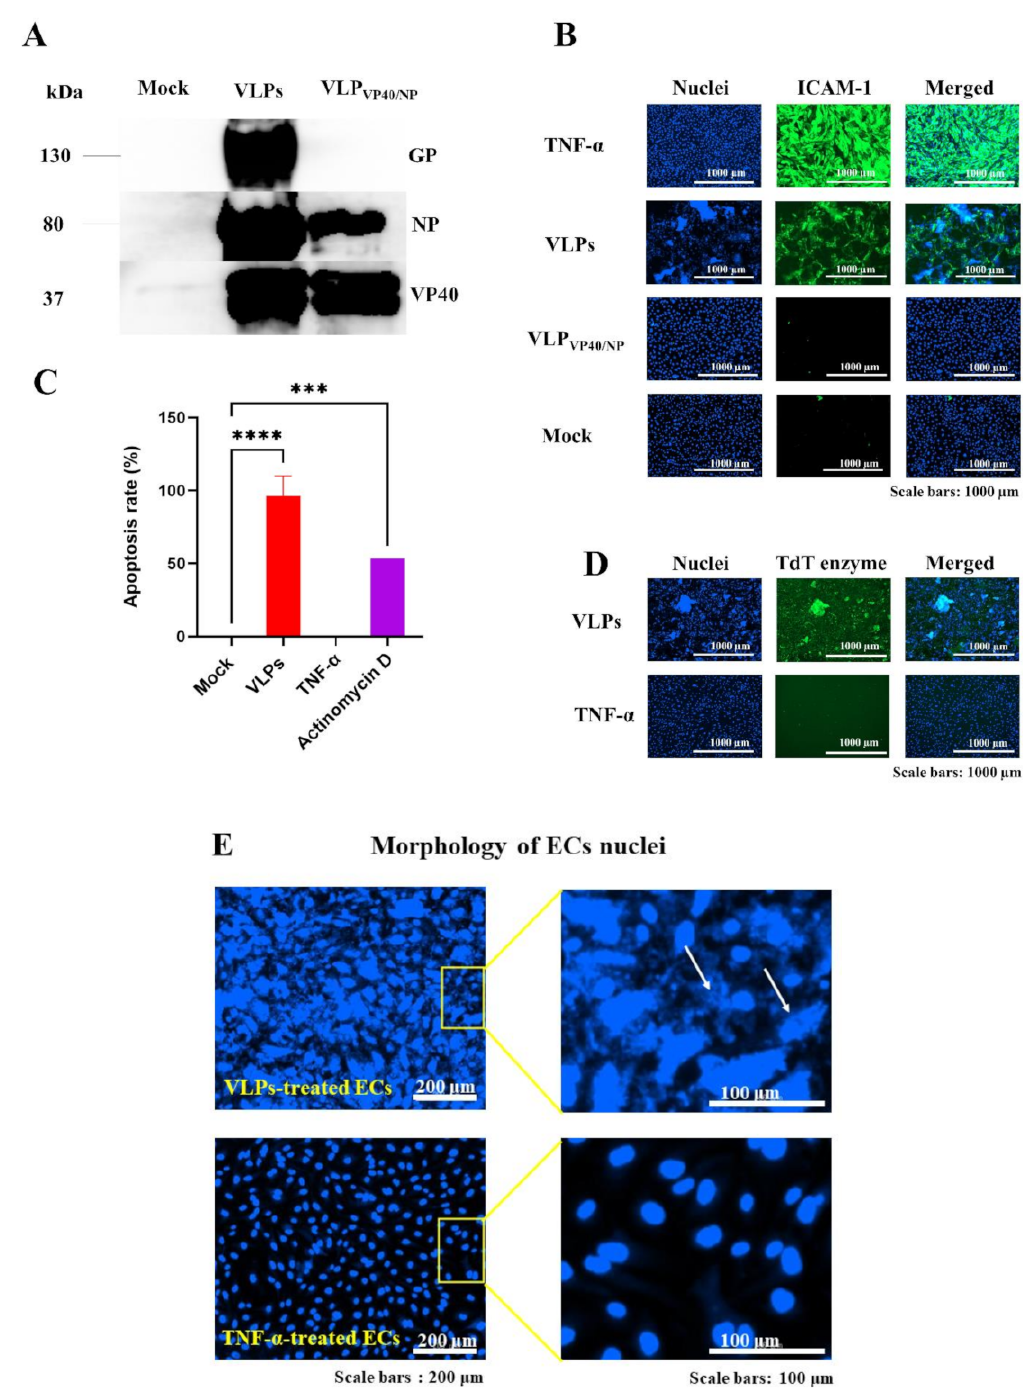
Figure 1. Ebola VLPs activate ECs and induce apoptosis. ( A ) The different VLPs preparations were purified from supernatants of transfected HEK293T cells and characterized using Western blotting with monoclonal antibodies (anti-GP, anti-VP40, and anti-NP). Supernatants from non-transfected cells were used as the negative control (Mock). Characterization with anti-GP indicated the absence of GP in VLP VP40/NP . ( B ) ECs were exposed to VLPs (10 × dilution) or VLP VP40/NP (10 × dilution)